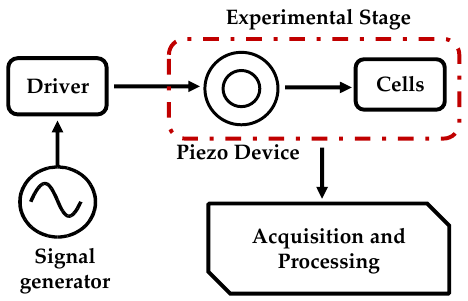
Figure 1. Schematic representation of the completely mechanical stimulator.